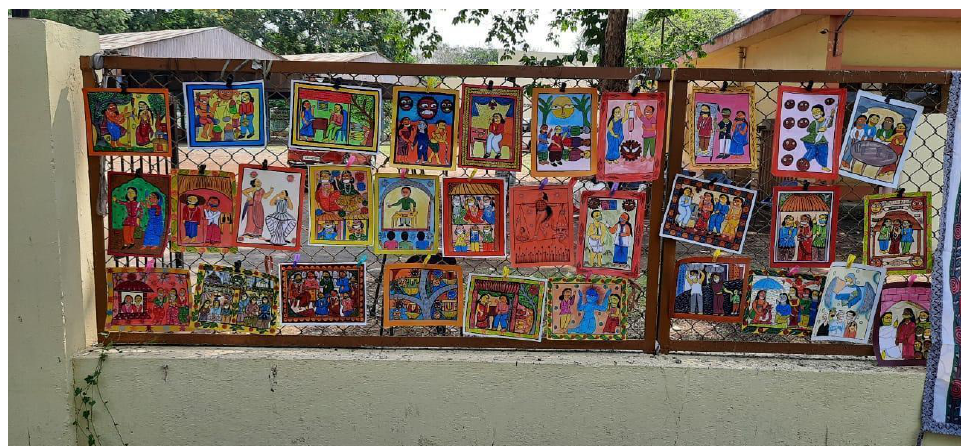
Figure 6. Poster Exhibition and Live Performance by Naya Patuas Outside Farmers’ Market in IIT Kharagpur, 18 April 2021. Curated by Anjali Gera Roy for Project “Folk Artists in the Time of Coronavirus”.